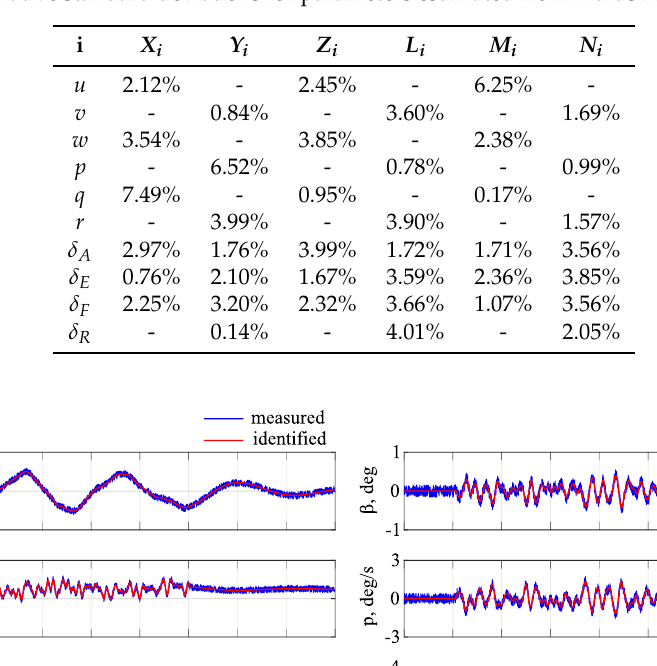
Table 6. Relative standard deviations for parameters estimated from multisine experiments.